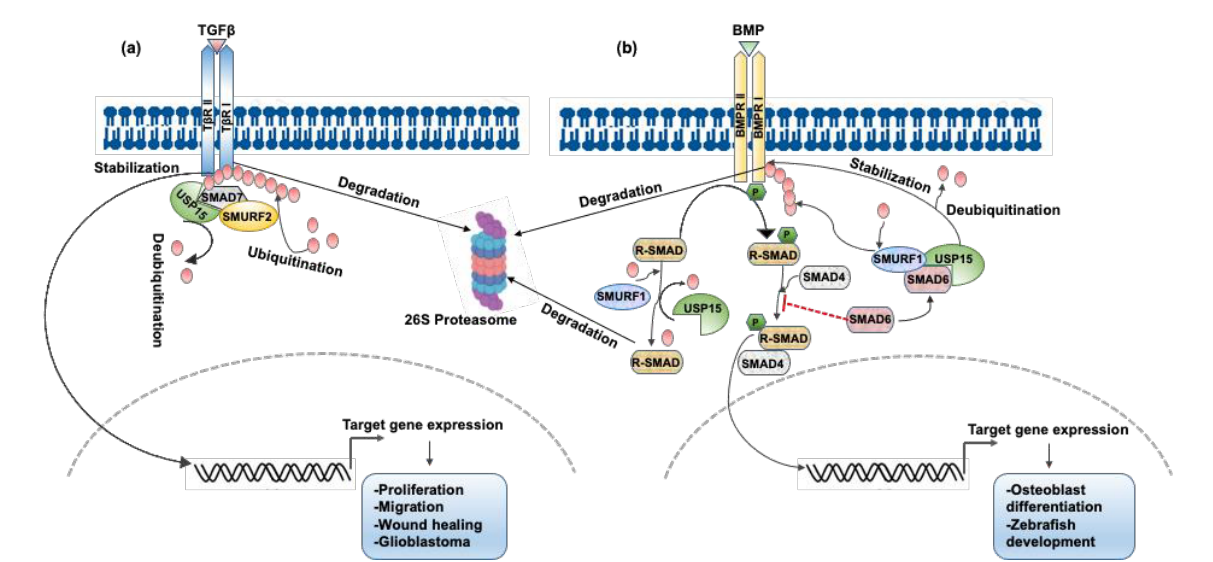
Figure 1. USP15 in the regulation of TGF-β and BMP signaling. ( a ) USP15 binds to SMAD7 and opposes SMURF2-mediated ubiquitination of TβRI. The deubiquitination and stabilization of TβRI by USP15 promotes TGF-β activity and triggers the downstream gene expression to stimulate cell proliferation, migration wound healing, and glioblastoma pathogenesis [13]. ( b ) Upon activation by BMP ligands, the receptor-regulated R-SMADs undergo phosphorylation, bind to SMAD4, and enter the nucleus to induce target gene transcription. SMAD6 is a negative regulator that competes with SMAD4 to bind to R-SMADs and induces SMURF1-mediated ubiquitination and degradation of R-SMADs. Through its interaction with SMAD6, USP15 deubiquitinates and stabilizes BMPR1 and R-SMADs to enhance the BMP signaling and elicit target gene expression [39].